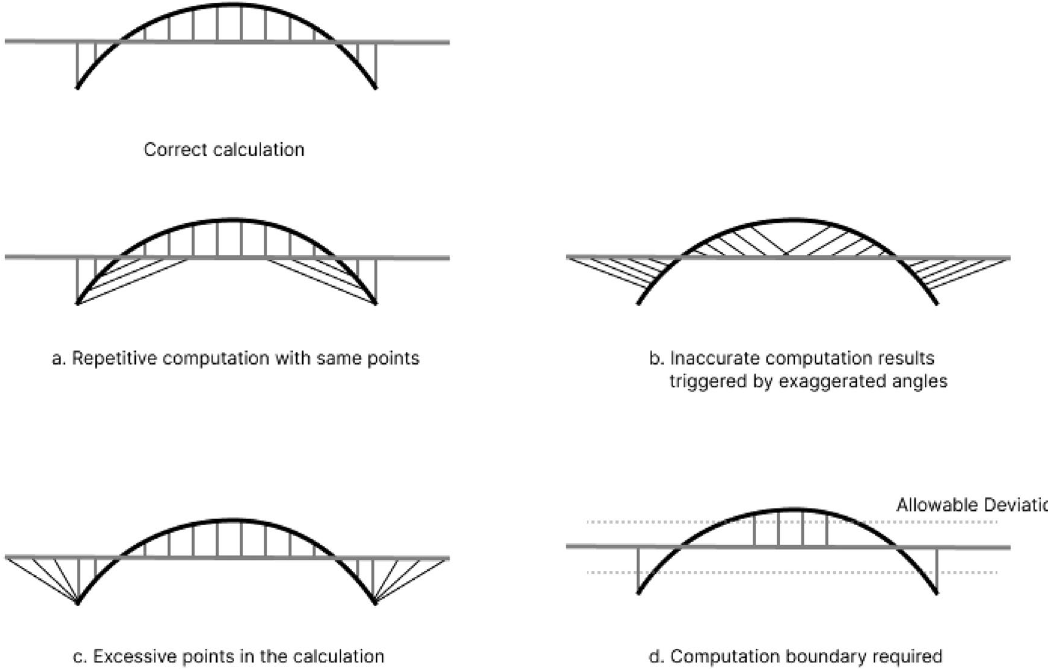
Figure 2. 2D diagram of Incorrect calculation situation (( a ) Repetitive computation with same points; ( b ) Inaccurate computation results triggered by exaggerated angles; ( c ) Excessive points in the calculation; ( d ) Computation boundary required).